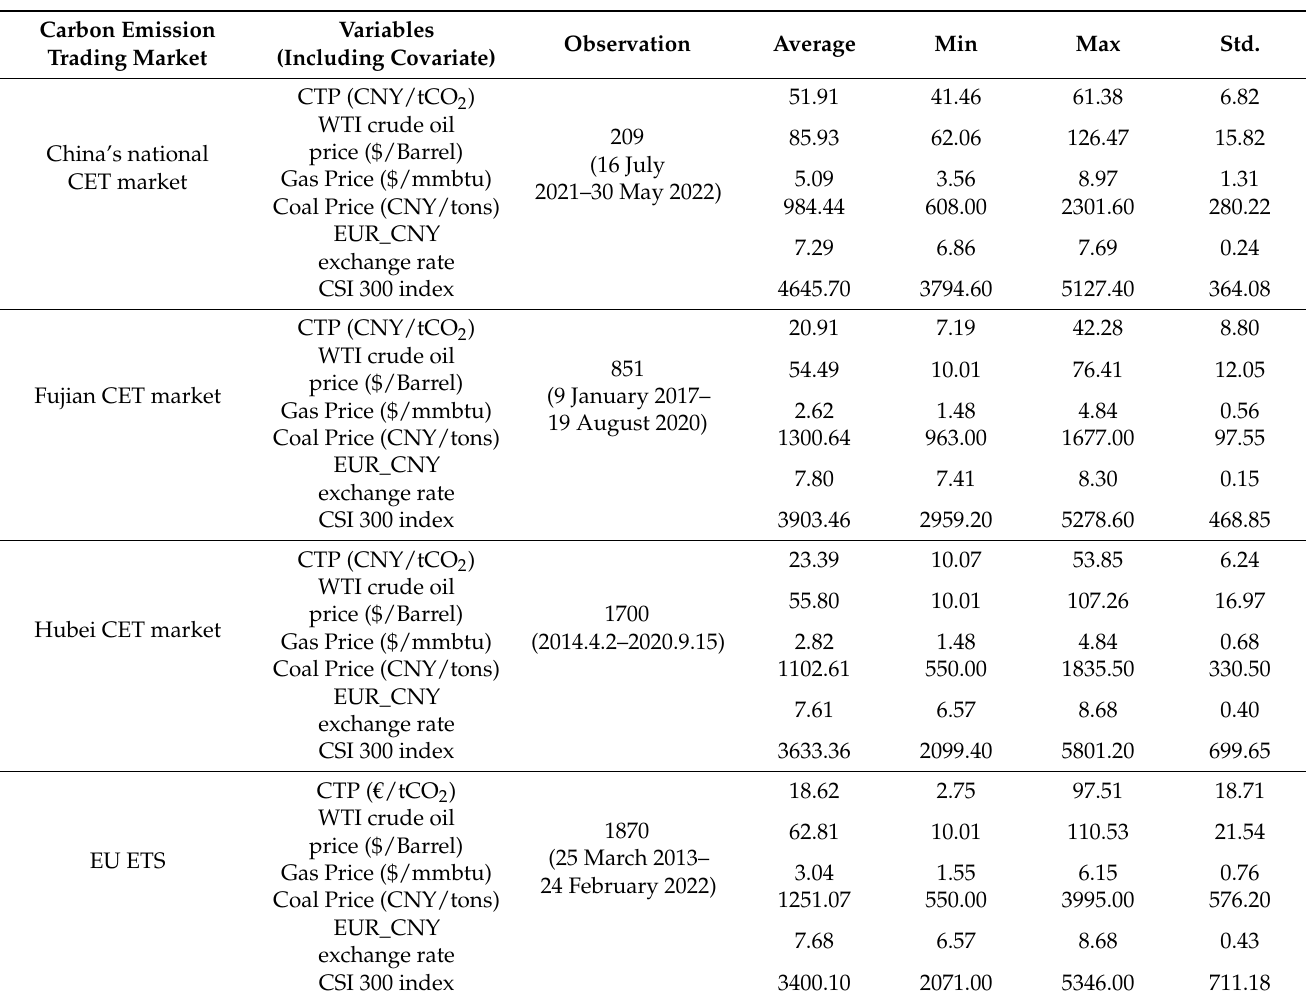
Table 2. The descriptive statistics of the